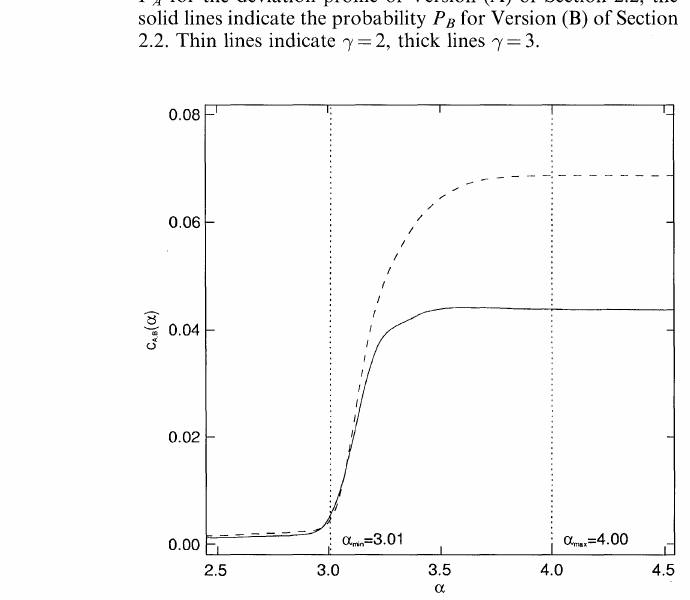
FIGURE 5 The profile crossing probabilities PA,B are the relative frequencies (as a function of area) with which the function Mcaki(a) exceeds the deviation profile, Mc,i(a) > c(a), somewhere in the range 3 < a <_ a The dashed lines indicate P A for the deviation profile of Version (A) of Section 2.2, the solid lines indicate the probability PB for Version (B) of Section 2.2. Thin lines indicate "7 2, thick lines "7- 3.